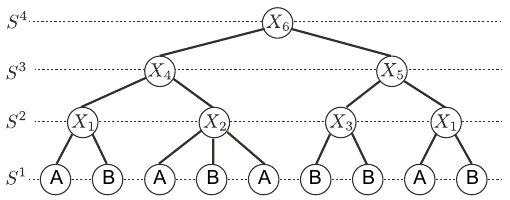
Fig. 1 Illustration of an ESP tree for string S =